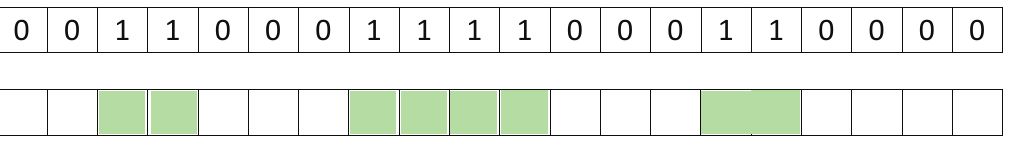
Figure 3. The state of grids in the global map memory block. The bit is set to true if the corresponding grid is not empty. We first query the list when we retrieve a grid in the global